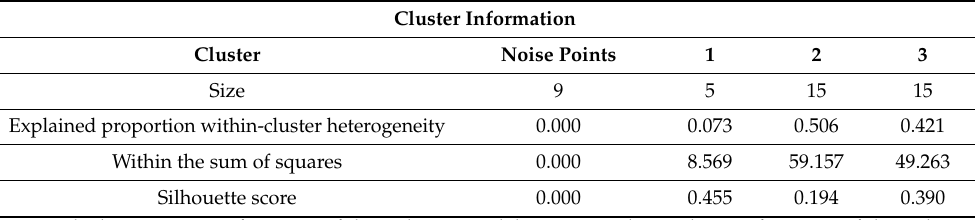
Figure 2. The simulated t-SNE cluster plot results of the dataset. From the t-SNE cluster plot result, it is not hard to see that there are some noise points (defects) in the obtained dataset. Additionally, from the dataset, we can easily see that the trained and validated data in the k-mean clustering algorithm have been classified automatically into three (3) different clusters, which also show their size, heterogeneity, and silhouette score. The silhouette score is used to determine the quality, performance, and similarity of the features in the clusters. In Tables 2 and 3 below, the cluster information for the dataset and the cluster mean values, respectively, have been presented.